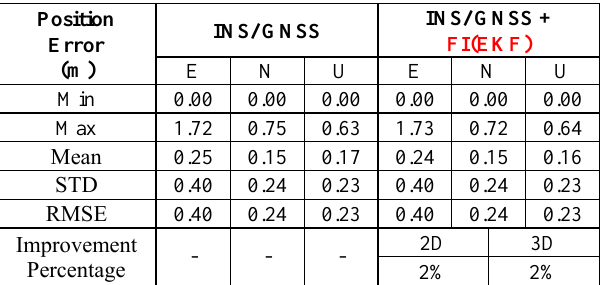
Table 4 . Performance analysis of FI method in